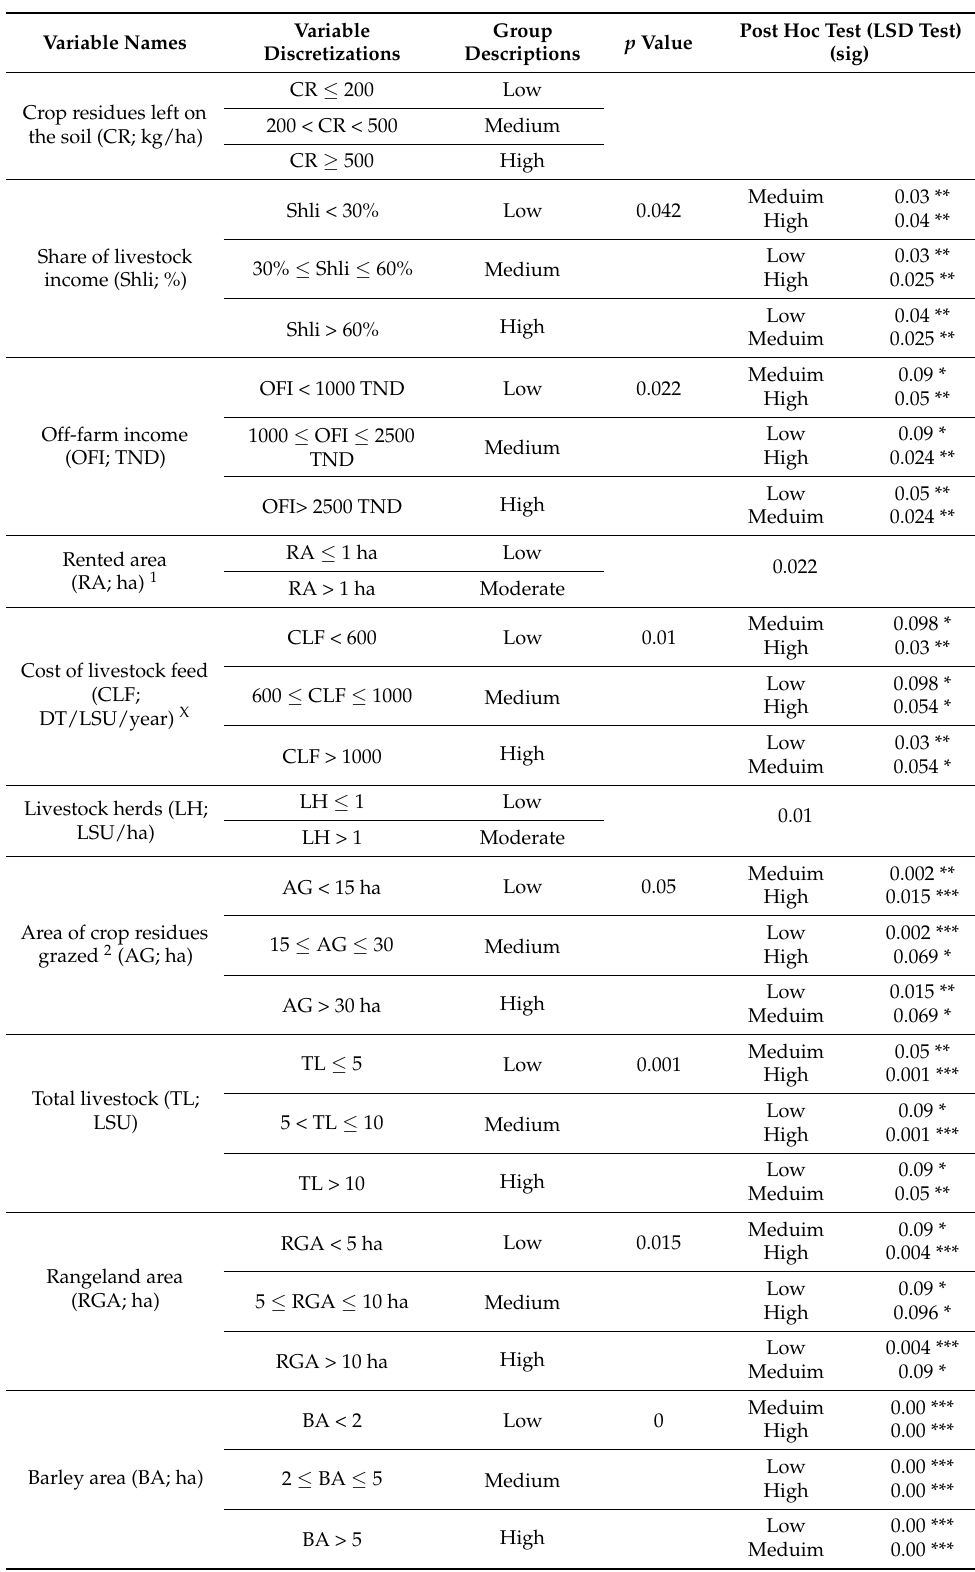
Table 1. Definition of discretization of variables used in the BBN causality for determining factors affecting the patterns of residue use in the study